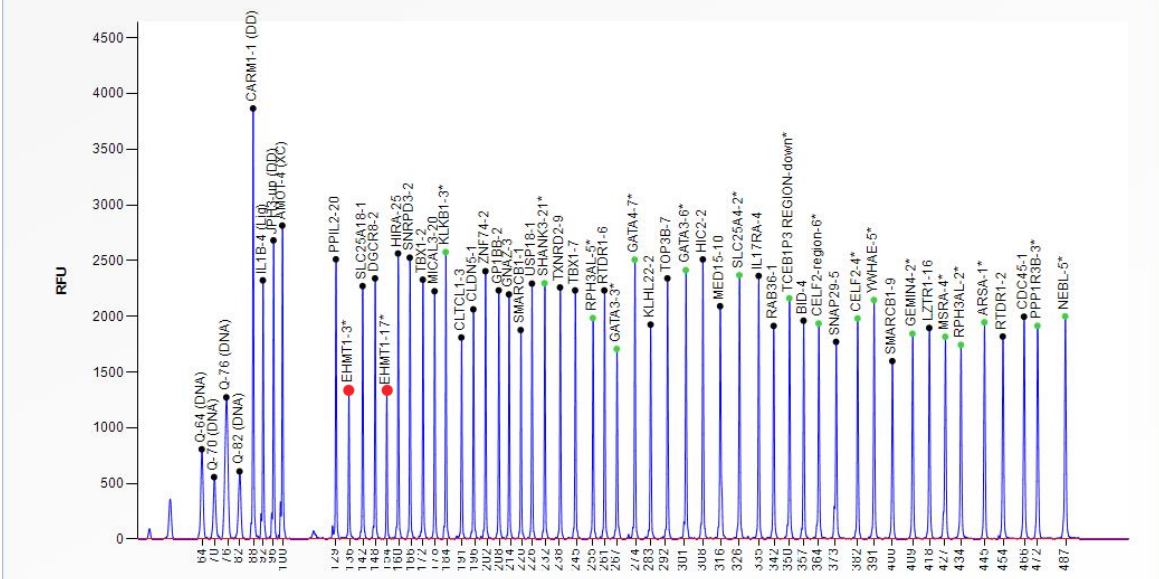
Fig. 1. The result from sample 3a analysed by Coffalyser software. Bigger red round points show a peak pattern in the deleted EHMT1 region (probe mix P250 DiGeorge